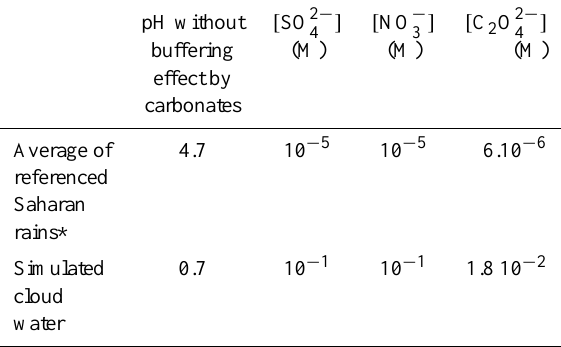
Table 1. Chemical composition of (1) desert dust-loaded rains in the Mediterranean environment and (2) simulated Mediterranean cloud water.